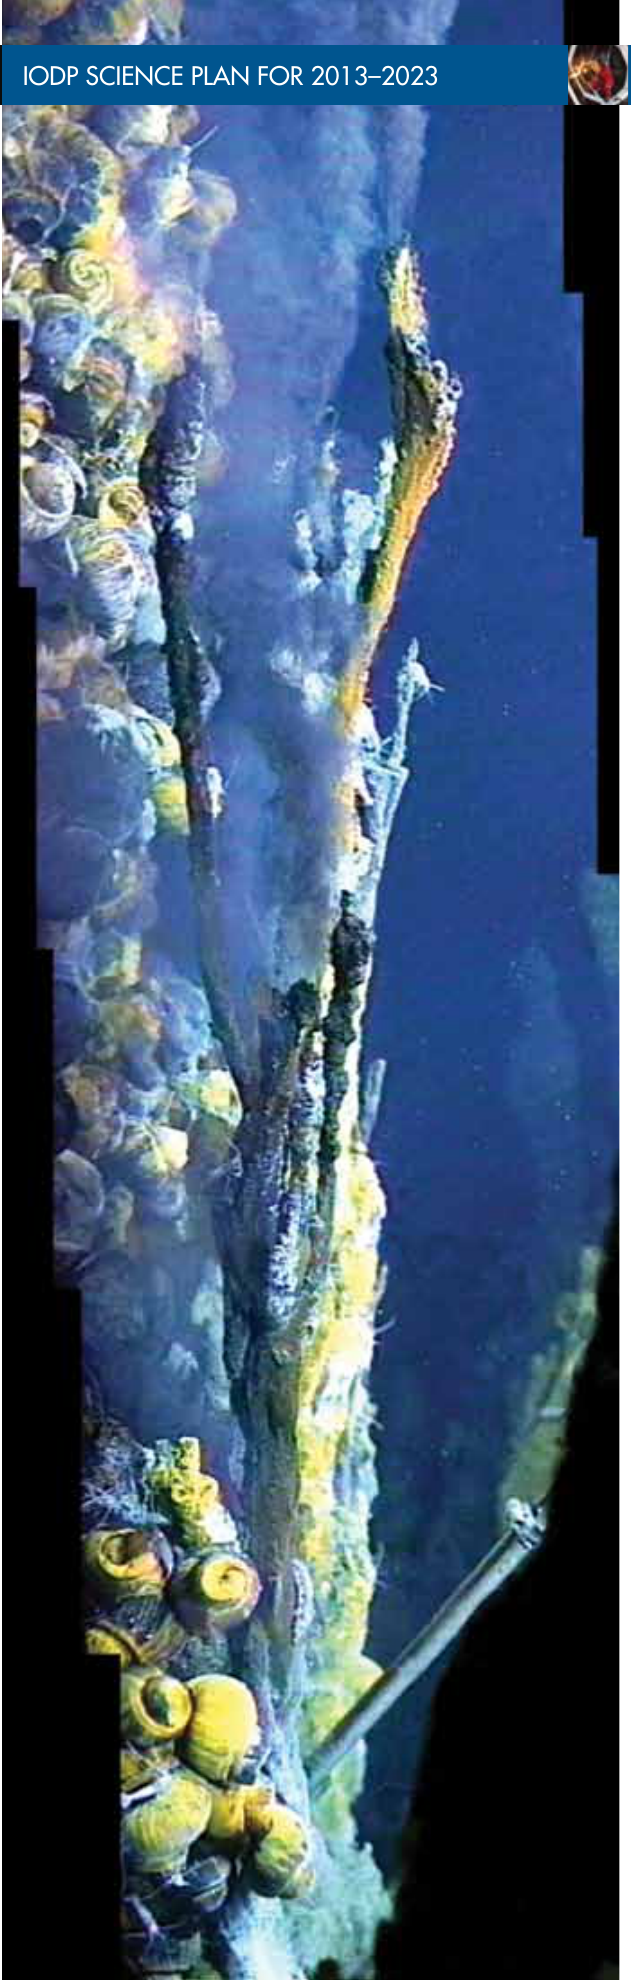
figure 4.2. delicate branching chimney struc- ture venting high-temperature fluids from the satanic mills chimney field, pacmanUs site, Bismarck sea, papua new guinea, provides a stunning example of the flow of chemicals and energy between the solid earth and ocean, and how hydrothermal systems sustain diverse and surprising ecosystems. conduit diameters are ~10 mm. video image from the Japanese Shinkai 6500 submersible, courtesy of the commonwealth scientific and industrial research